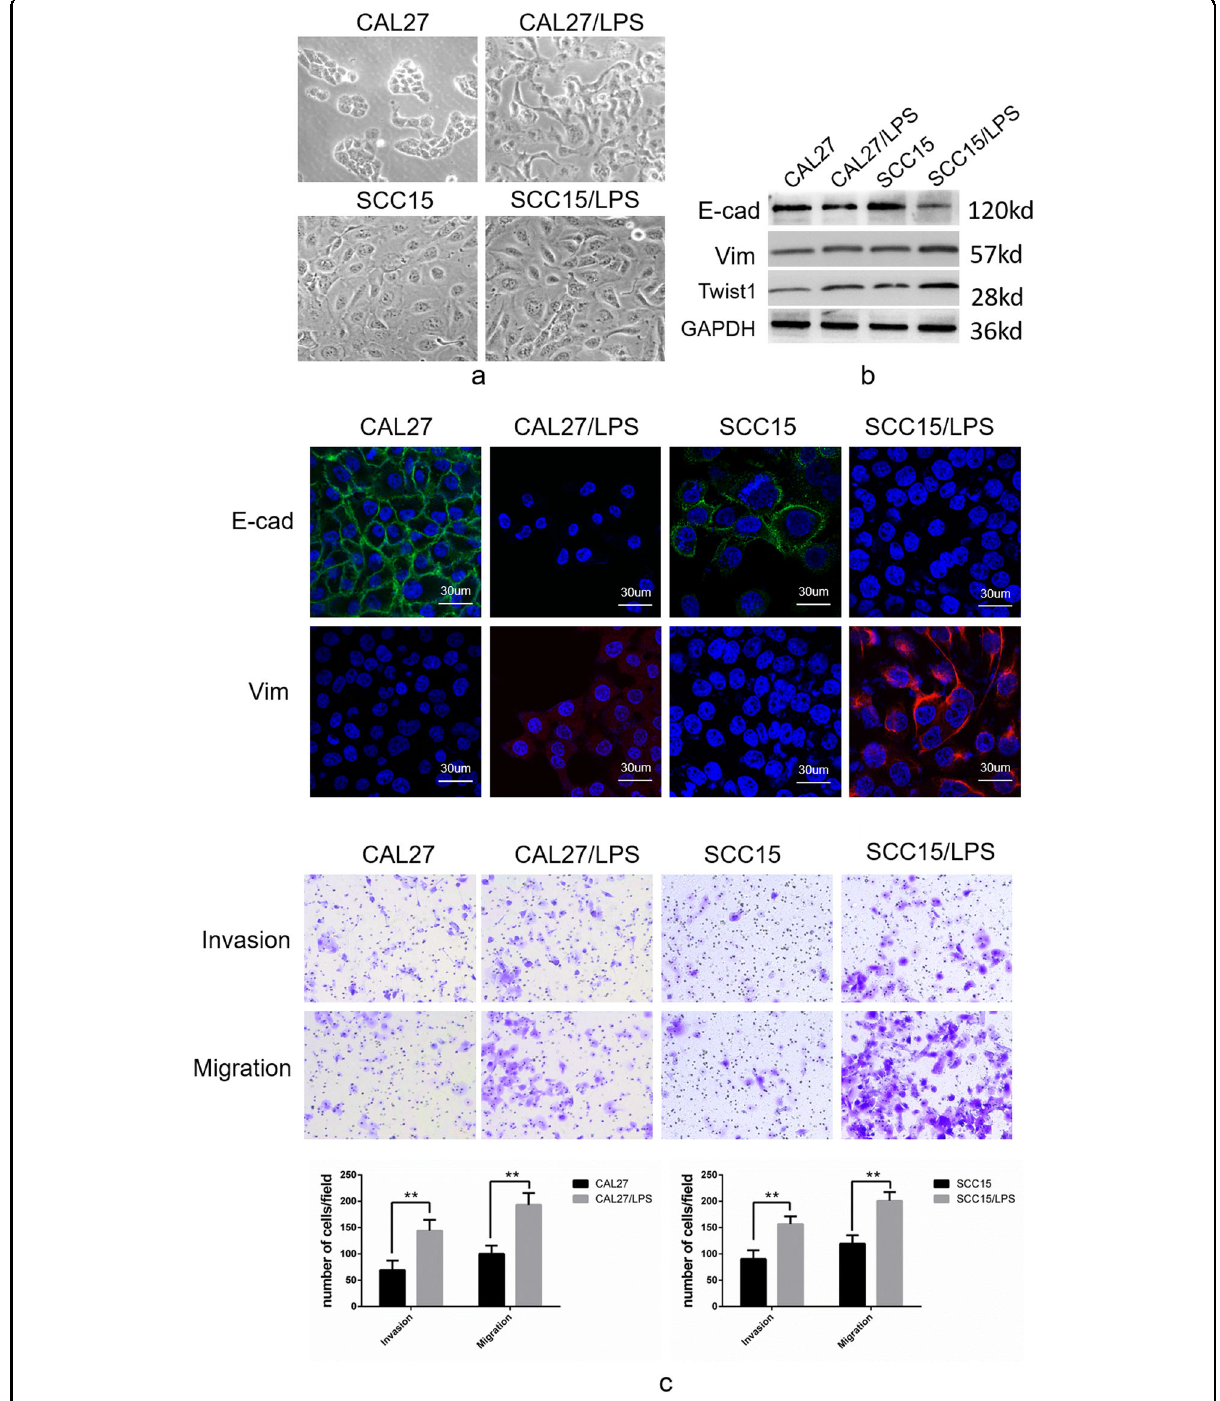
Fig. 1 Epithelial – mesenchymal transition (EMT) was induced in tongue squamous carcinoma cell lines by LPS from Porphyromonas gingivalis . a The morphological changes in CAL27 and SCC15 cells after P.g-LPS induction from a tightly connected epithelial phenotype to an evacuated interstitial phenotype (×200). b Western blot analyses showed that E-cadherin protein expression was decreased in CAL27 and SCC15 cells induced by P.g-LPS, whereas vimentin and the EMT-related transcription factor Twist1 protein levels were increased. c Immuno fl uorescence also showed a decrease in the epithelial marker E-cadherin and an increase in the interstitial marker vimentin. d Transwell invasion and metastasis assays con fi rmed that P.g-LPS-induced CAL27 and SCC15 cells showed higher invasion and metastasis than the control cells. Error bars represent the mean ±S.D from three independent experiments. (** P <